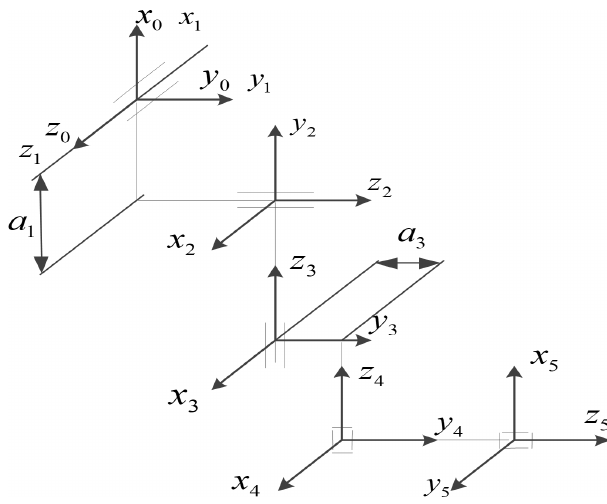
Figure 1. Coordinate system of 5 DOF rectangular coordinate ma- nipulator.